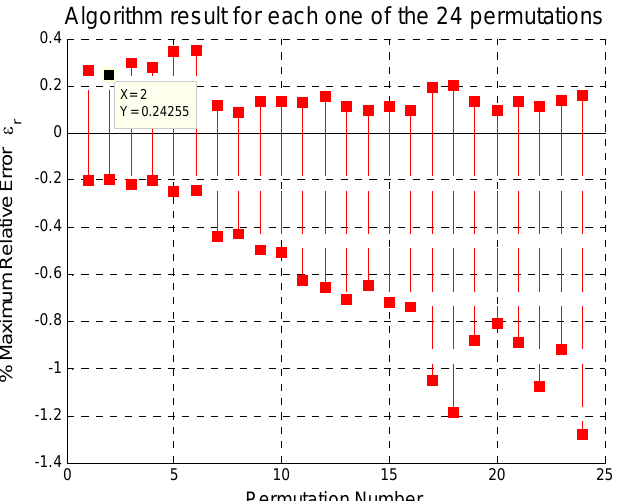
Figure 5. Percentage of nonlinearity error of PVA. Algorithm result for each one of the 24